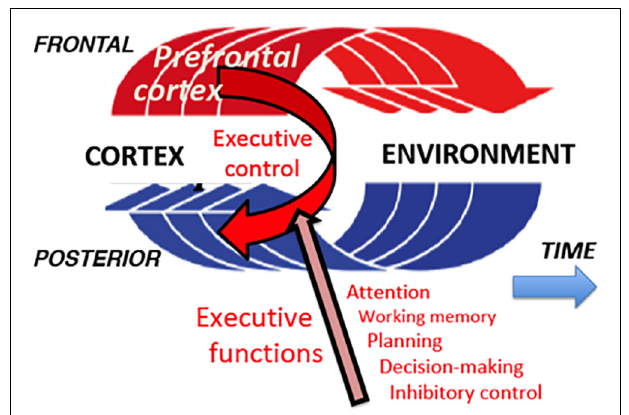
FIGURE 2 | Perception-action cycle. In a sequence of goal-directed actions, each action causes a change in the environment, which generates sensory impulses; these impulses are analyzed in the posterior association cortex (in perceptual long-term memory), and the result of this analysis informs the frontal cortex (executive long-term memory) for the next action. And so on and so forth, cycle after cycle, until the behavioral goal is reached. At every turn of a cycle, the prefrontal cortex matches percept and action to the long-term memory of both in the present context, and exerts updated executive control of them through its executive